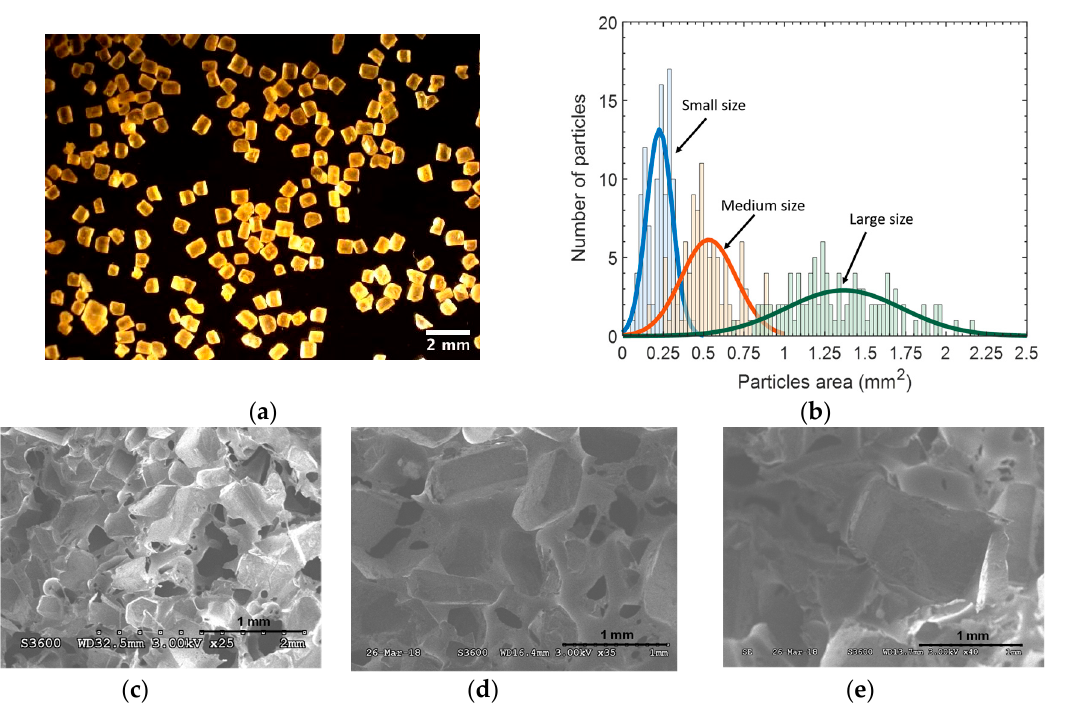
Figure 3. ( a ) Small sugar particles observed with an optical microscope; ( b ) Size distribution of sugar particles after the sieving procedure; ( c – e ) SEM images of the cross-section of microporous PDMS foams featuring small, medium, and large pores, respectively.